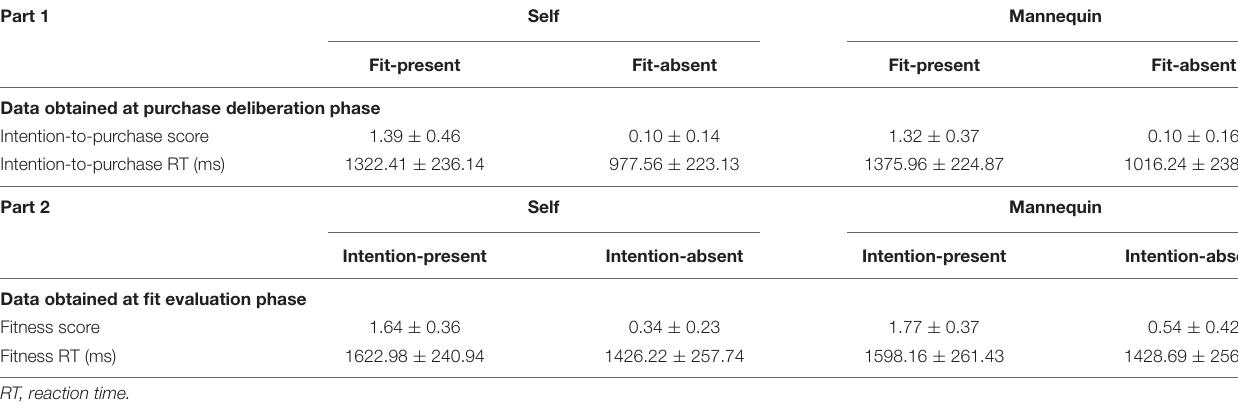
TABLE 1 | Summary statistics (mean ± SD) of behavioral data.